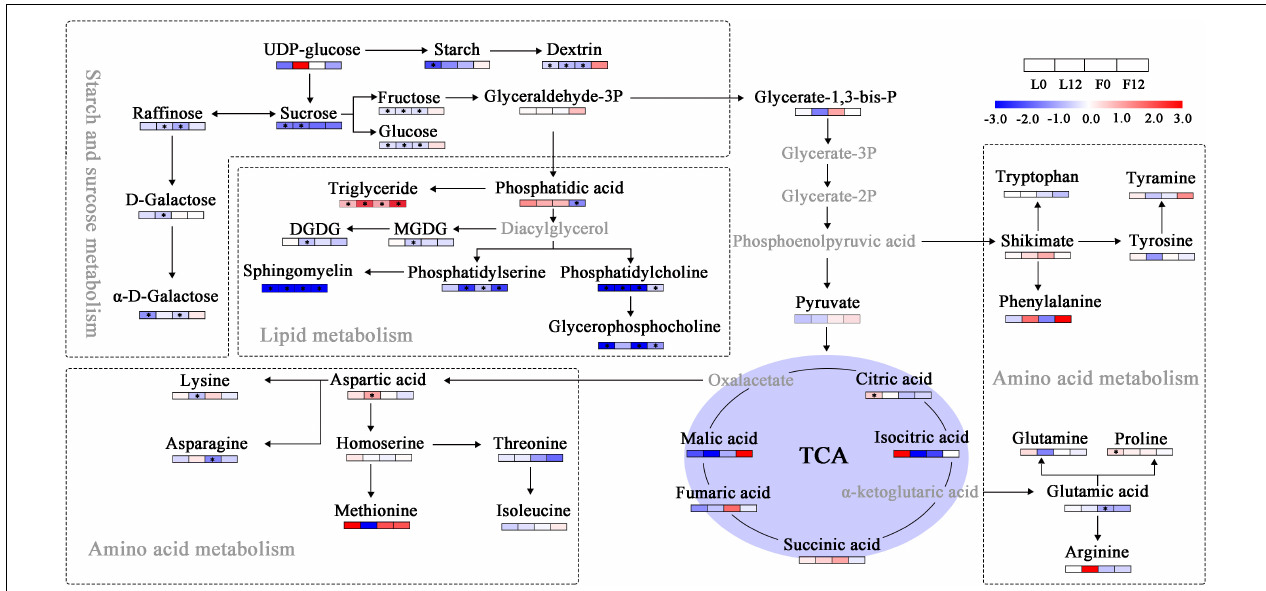
FIGURE 7 | Changes in sugars, lipids, and amino acids in tricarboxylic acid cycle (TCA) metabolism. Blue and red boxes, respectively, represent metabolites with lower or higher abundance under S fumigation. The white boxes represent metabolites with unchanged abundances. The gray letters represent undetected metabolites. * indicates DEMs with P -value < 0.05 and VIP > 1. DGDG, digalactosyldiacylglycerol; MGDG, monogalactosyldiacylglycerol.